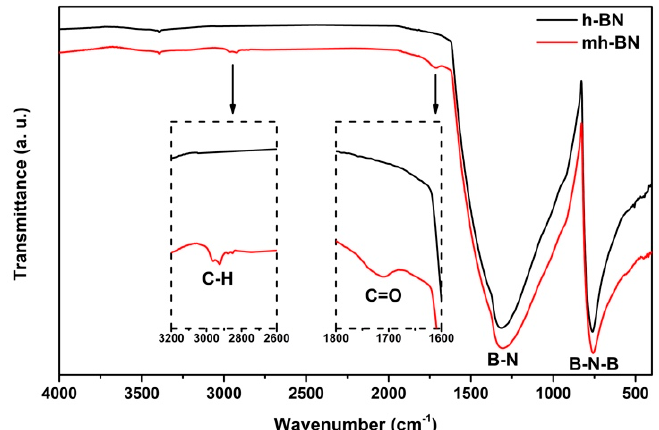
Figure 2. Infrared spectra of unmodified (h-BN) and plasma-modified (mh-BN) nanoparticles.